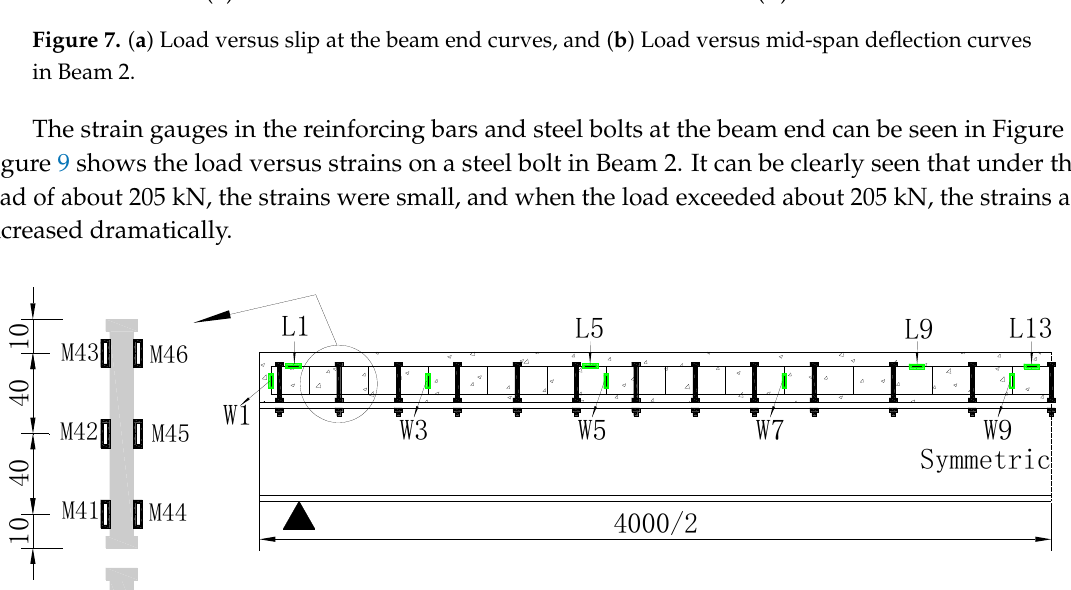
Figure 8. The locations of the strain gauges in Figures 9–11.